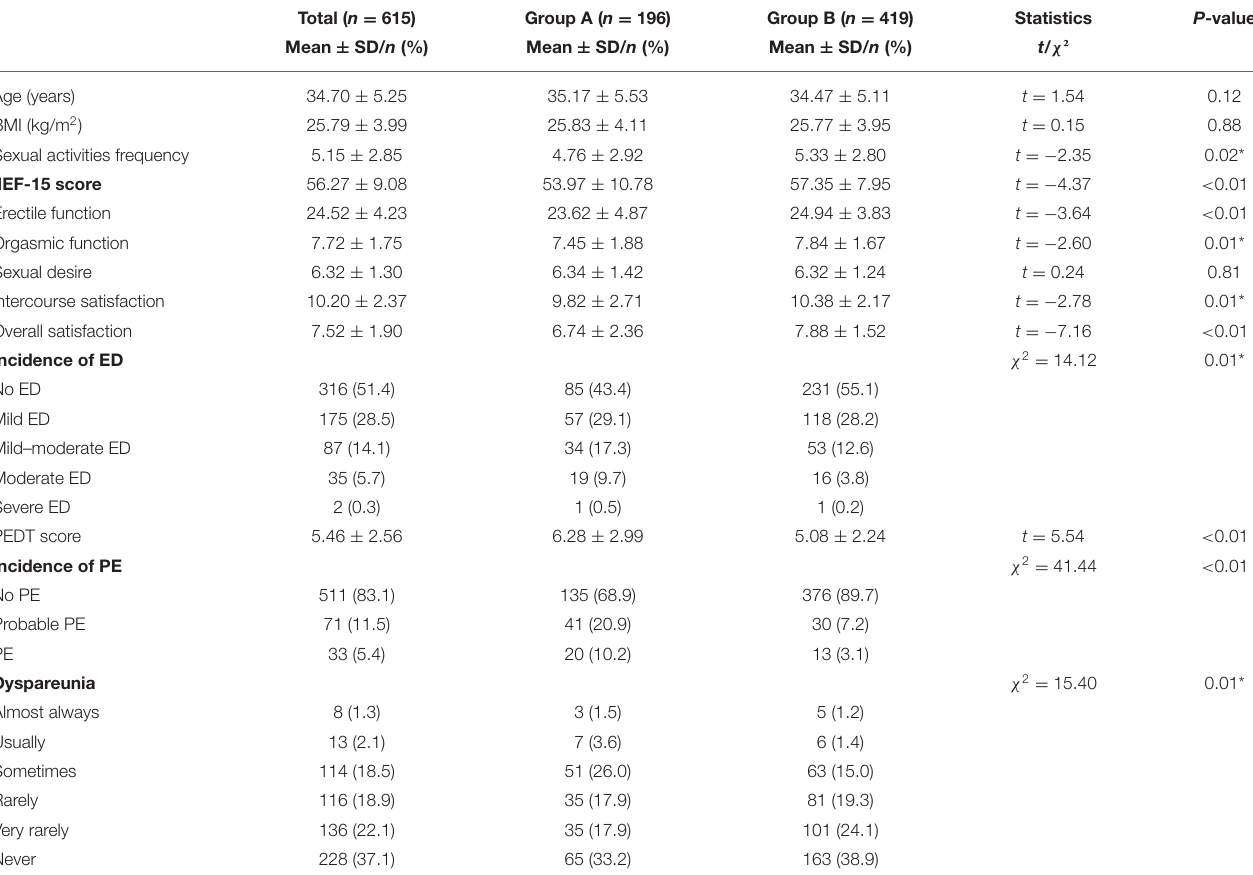
TABLE 4 | Male sexual health during COVID-19 pandemic.